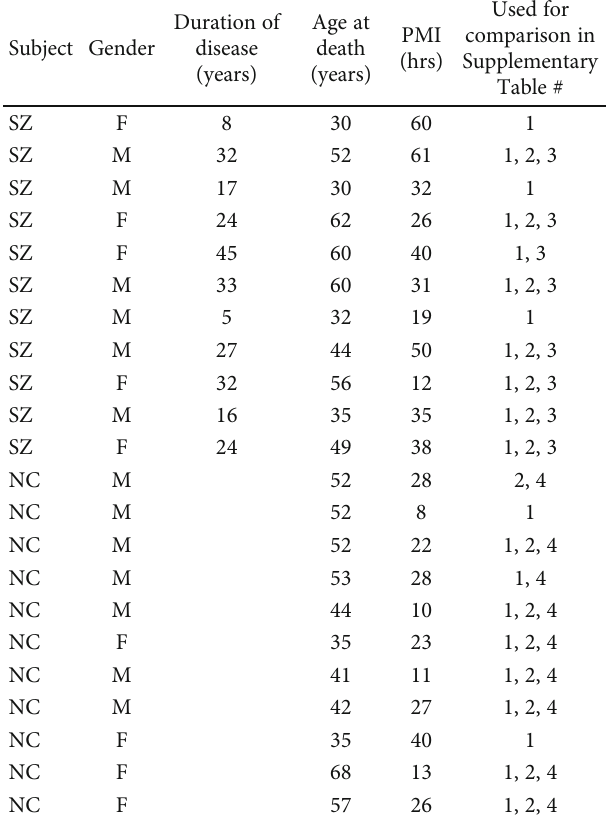
Table 1: Demographics. Total number of subjects ( n = 22 ), schizophrenia cohort ( n = 11 ), and normal control cohort ( n = 11 ) for anterior nucleus (AN), and ventral posterior lateral (VPL) comparisons (Supplementary Tables 1 – 9). Female (F), male (M), and postmortem interval (PMI). From the original cohort ( n = 15 each, SZ or NC), samples with failed neuron-capture or probe sets with low intensity values or outliers (poor RNA quality or hybridization) were